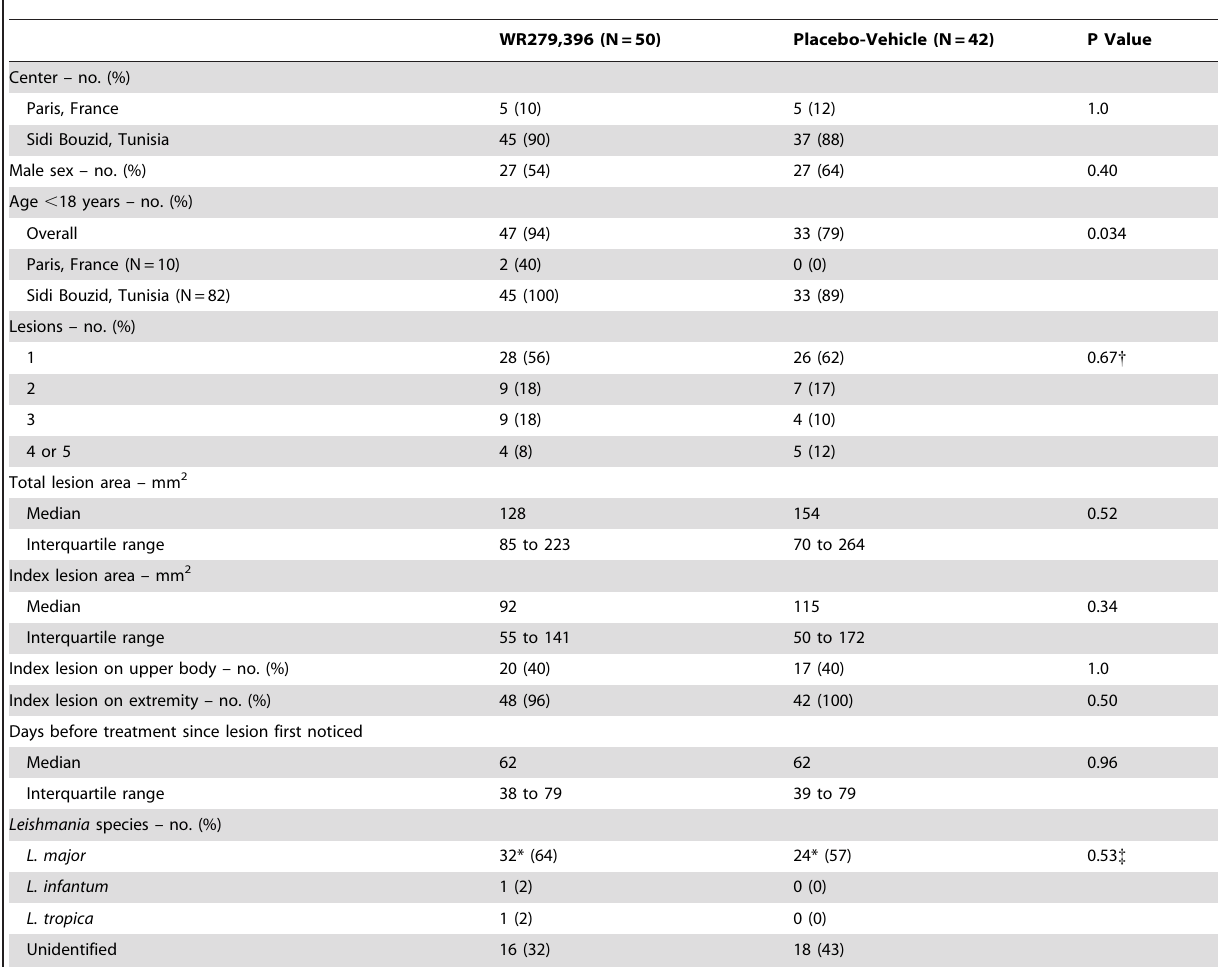
Table 1. Baseline Characteristics of the